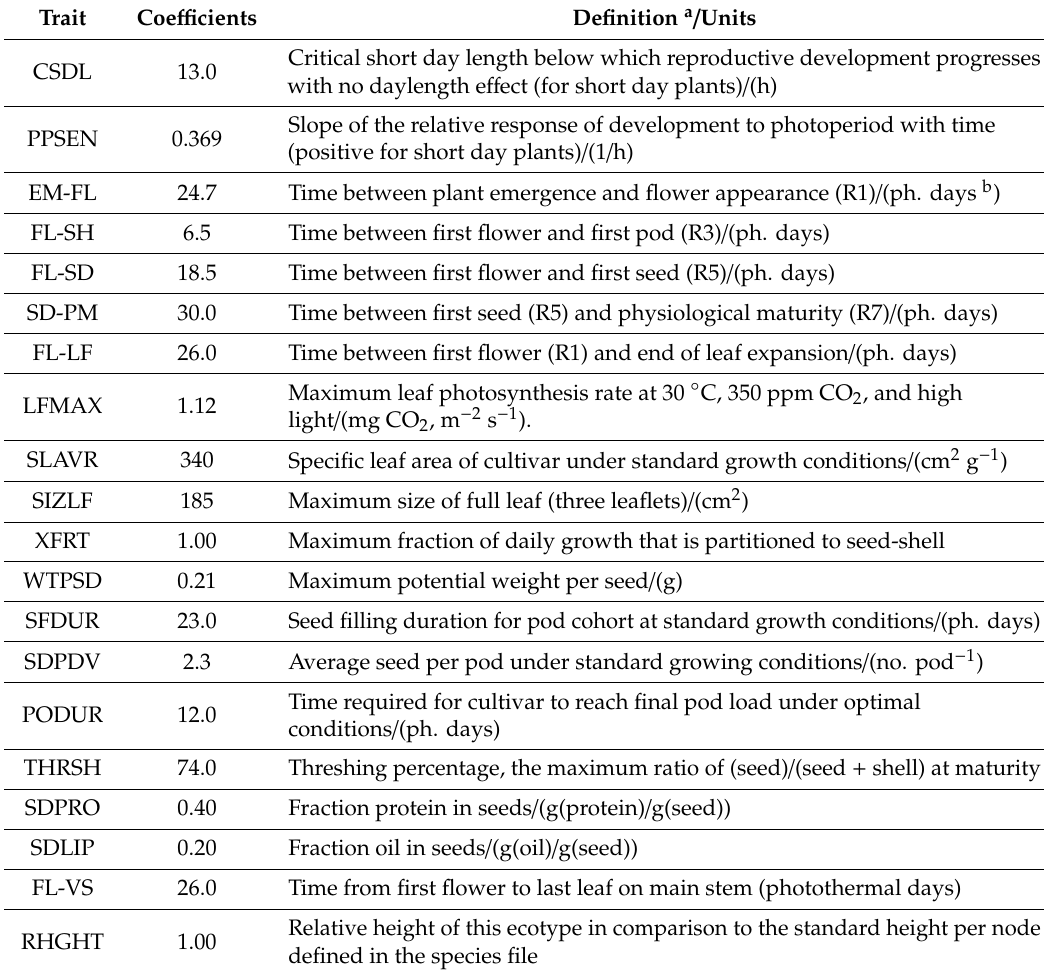
Table 2. Genetic coe ffi cients for the soybean cultivar of the Relative Maturity Group 8.5 used for calibration of the DSSAT-CROPGRO-Soybean